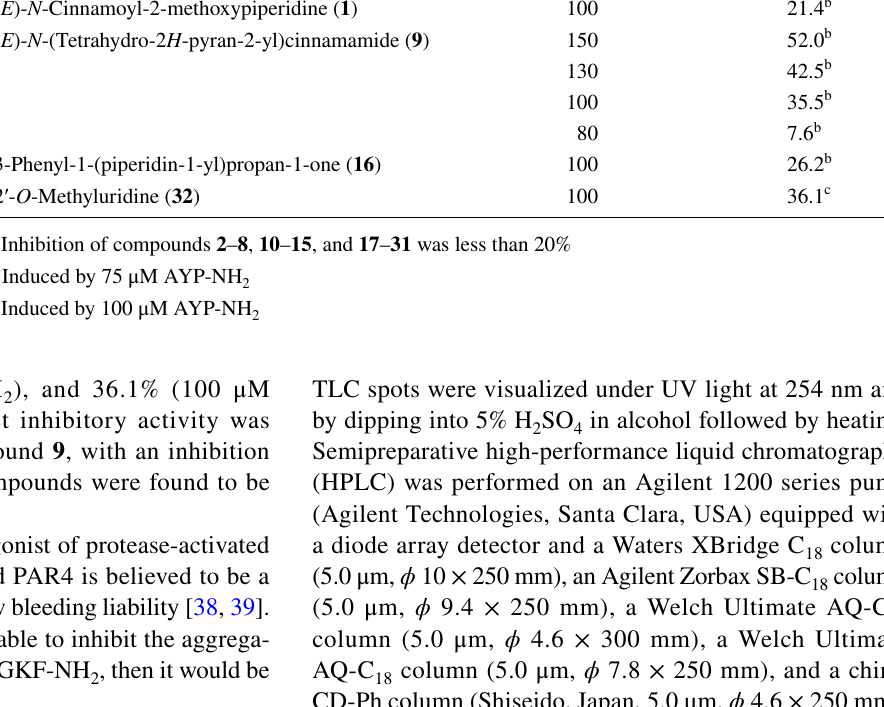
Table 5 Inhibitory effects of compounds from Piper retrofractum on mouse platelet aggregation induced by AYPGKF-NH